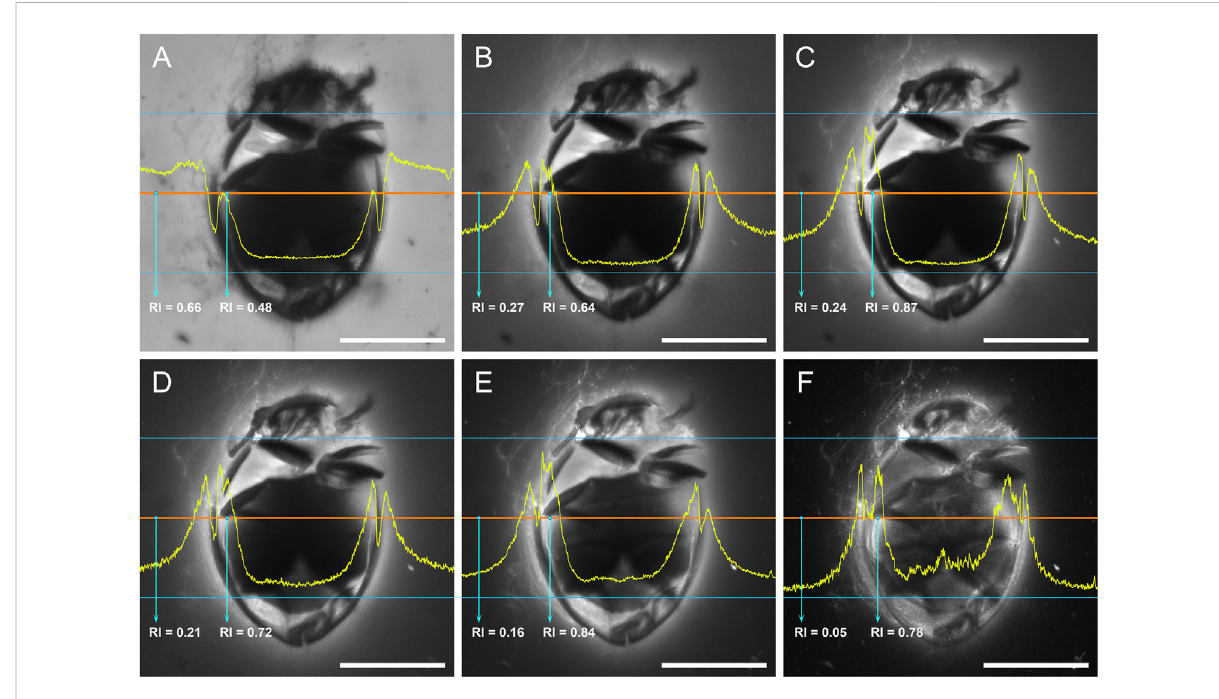
FIGURE 7 Crowsonaerius minutus in amber under confocal microscopy, excitedwith laser ofdifferent wavelengths. The yellow pro fi le shows the relative intensity (RI) along the mid-section (red line). (A) 405 nm (Diode 450-30). (B) 458 nm (Argon). (C) 488 nm (Argon). (D) 514 nm (Argon). (E) 561 nm (DPSS 561-10). (F) 633 nm (HeNe633). Scale bars: 200 μ